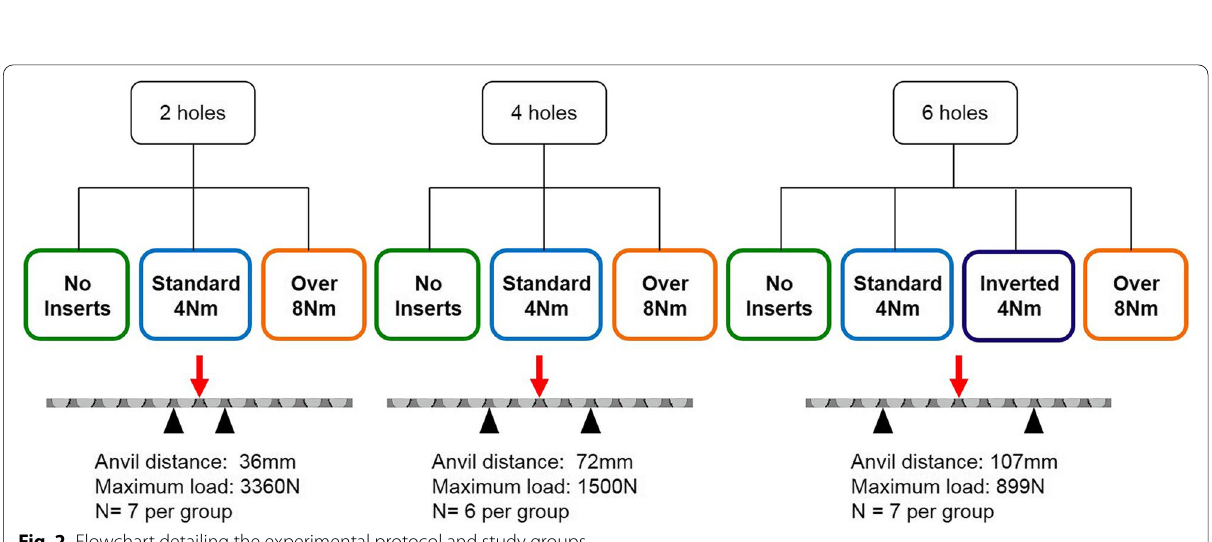
Fig. 2 Flowchart detailing the experimental protocol and study